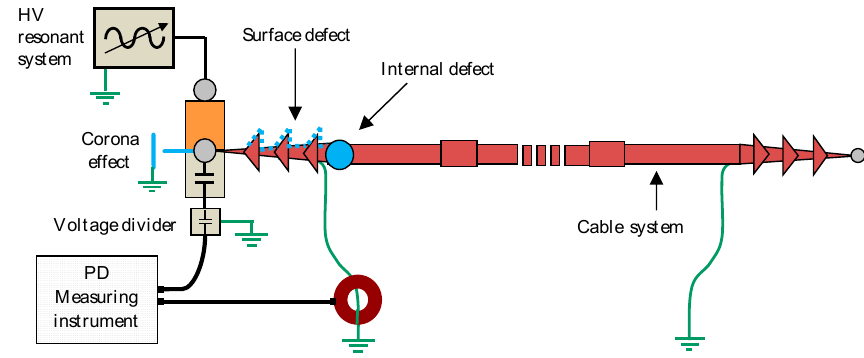
Figure 7. Experimental setup composed by the HV resonant generator, cable system with three defects, HFCT sensor and measuring instrument.